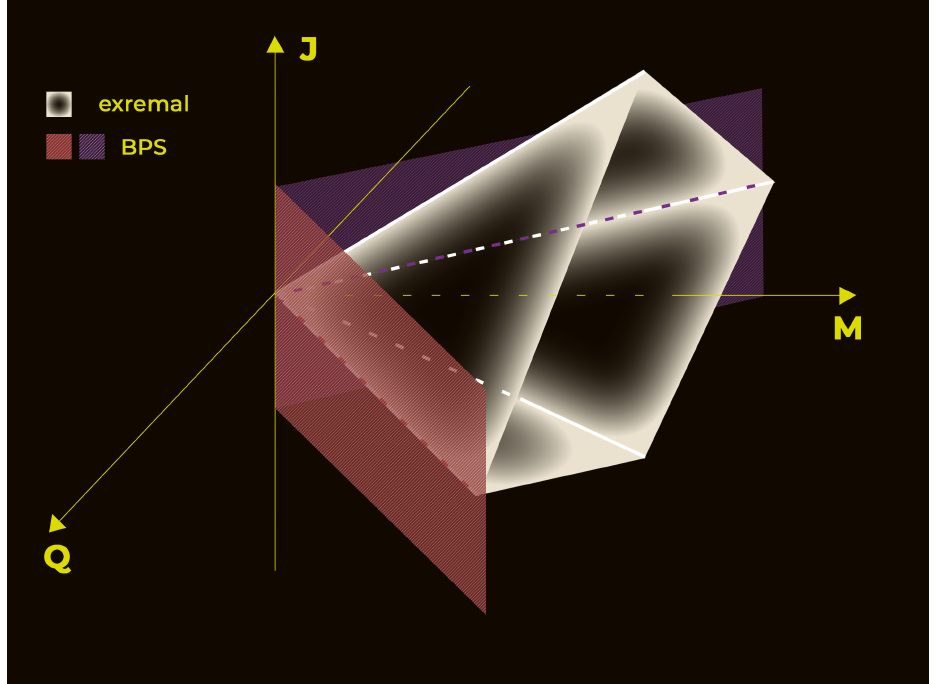
Figure 1 . The black hole solution space in the case where only mass ( M ), angular momentum ( J ), and a single electric charge ( Q ), are allowed. The sides of the pyramid are the extremal black holes, while the inside is populated by the conventional thermal solutions (the base extends to M → ∞